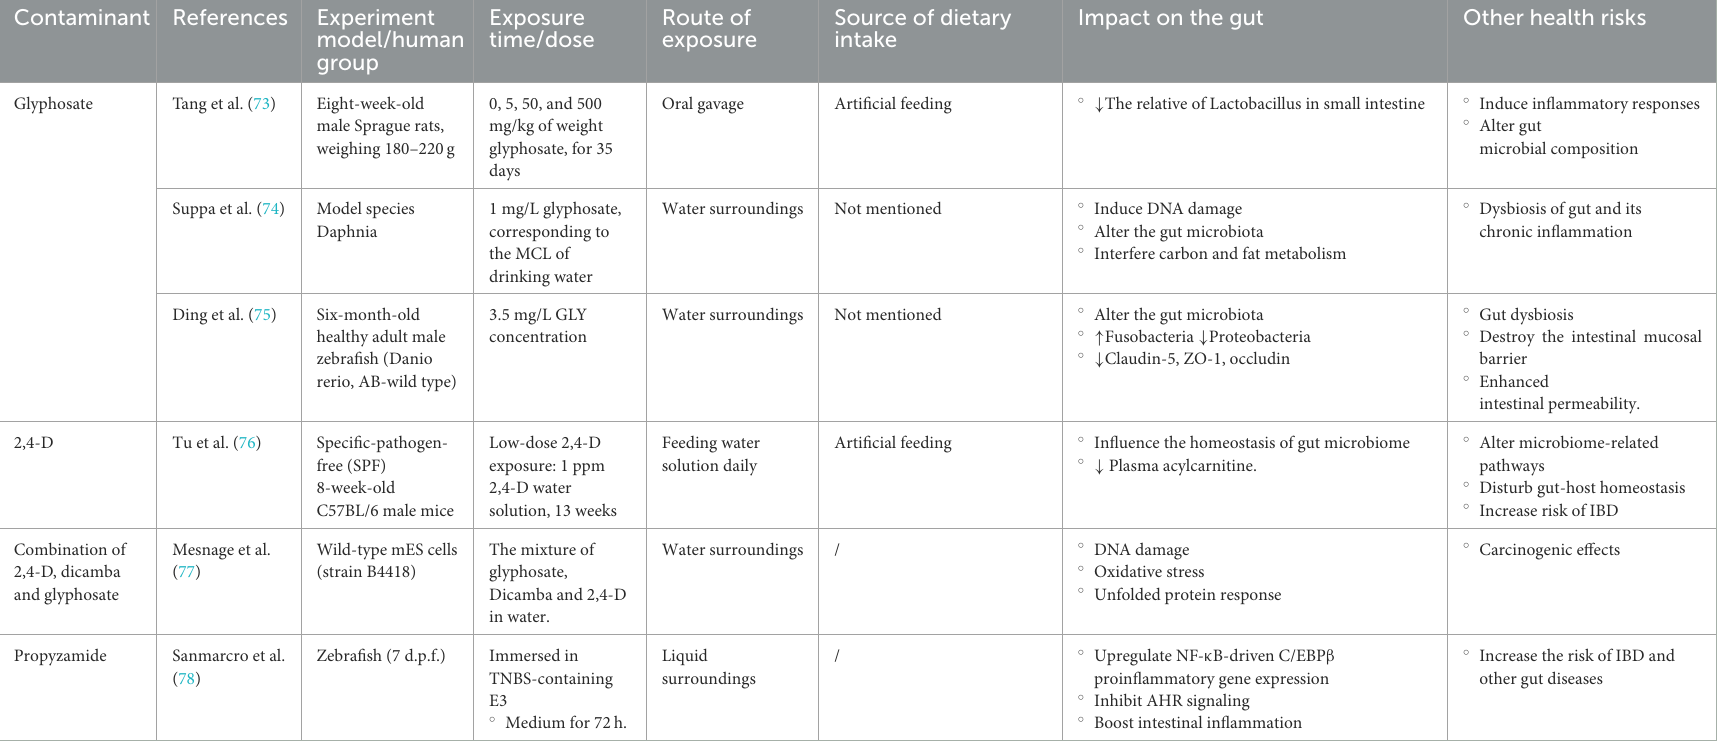
TABLE 3 Adverse health effect of chemical herbicides in inflammatory bowel